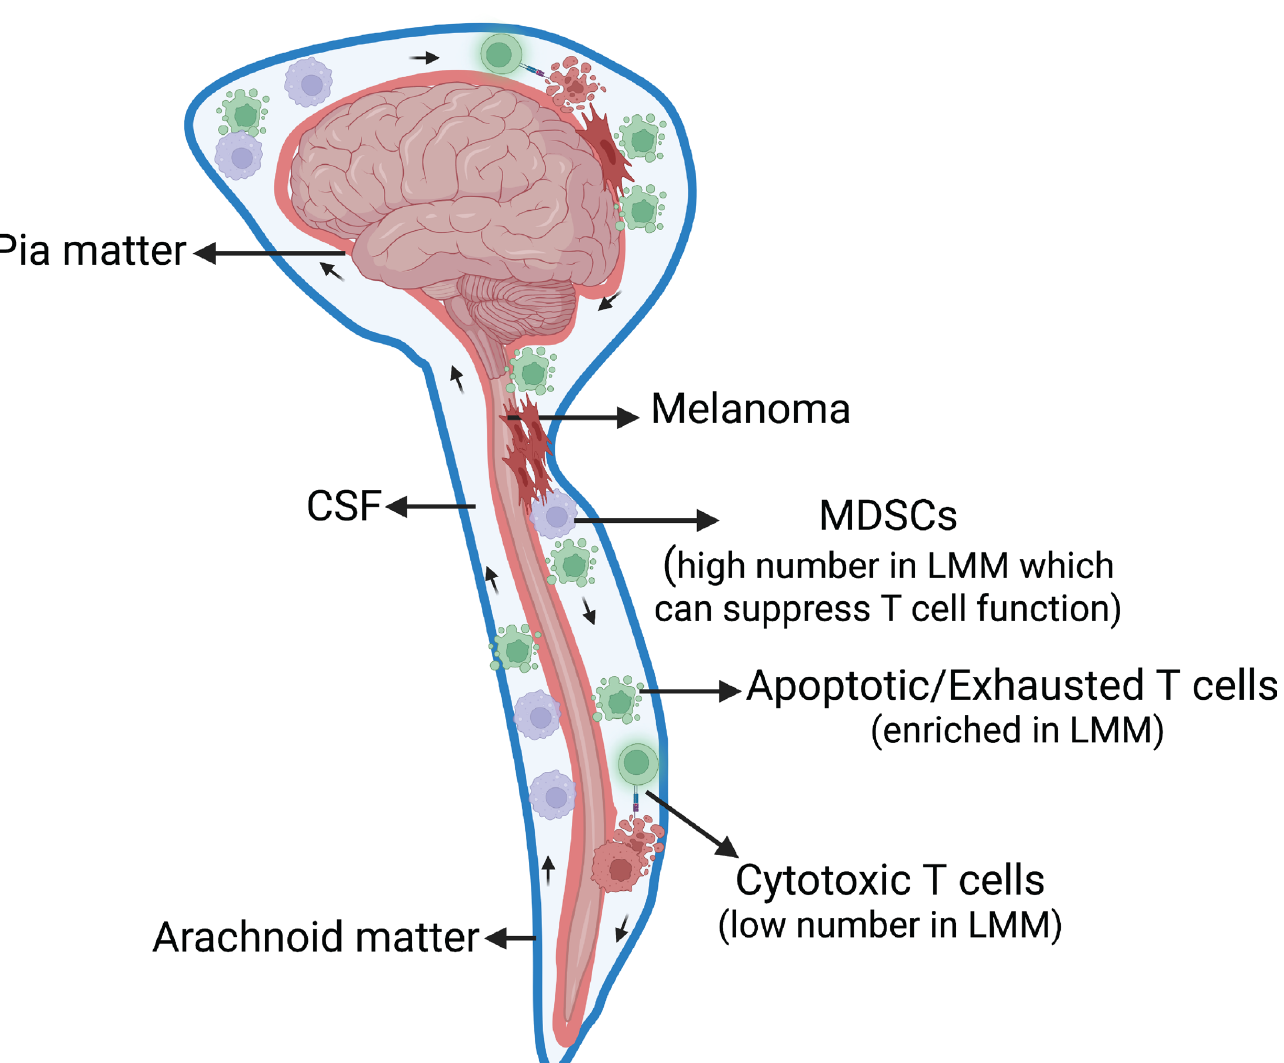
Figure 2. Tumor microenvironment of LMM . LMM CSF comprised a high number of apoptotic and exhausted CD4+ T - cells and a low number of CD8+ T - cells in addition to enrichment of MDSCs - like cells , indicating an immune - suppressed microenvironment ( [ 33 ] ).